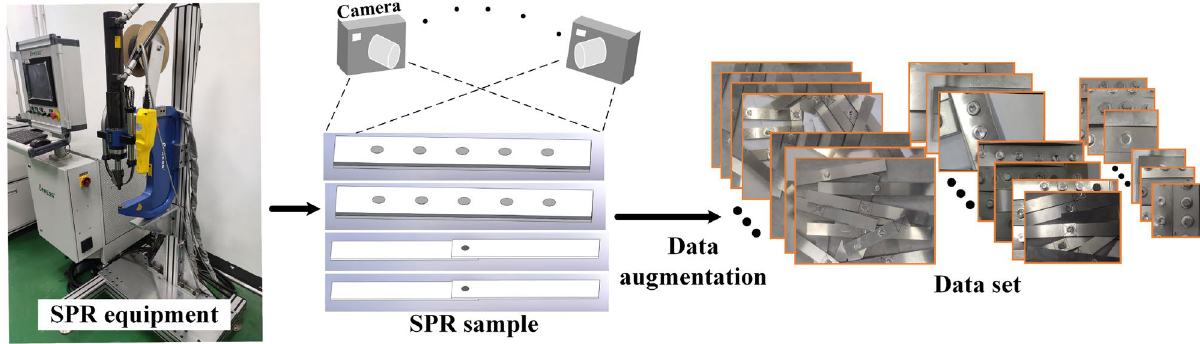
Figure 11. Experimental equipment, specimen types, and dataset construction.